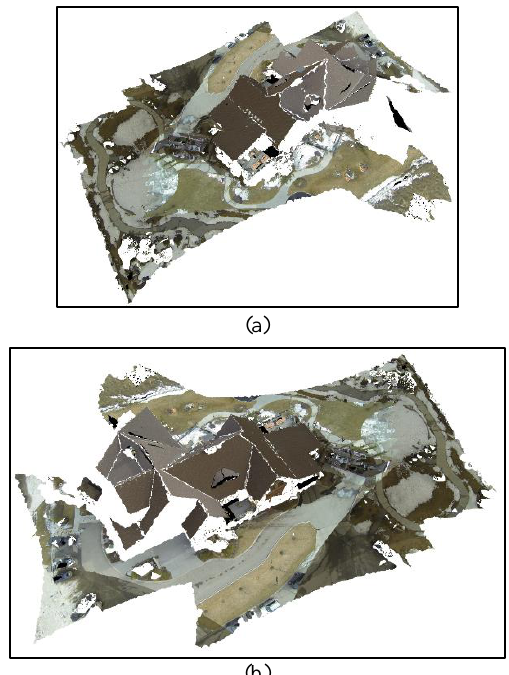
Figure 15. Two different views of a photo-realistic 3D model generated from UAV-borne photogrammetric data Qualitative evaluation of the reconstructed 3D models through visual inspection of Figures 14 and 15 verify the quality photo- realistic 3D surface reconstruction using overlapping images while considering the possible occlusions by different surfaces within the images. One should note that in these textured 3D models, the occluded areas are visualized in black